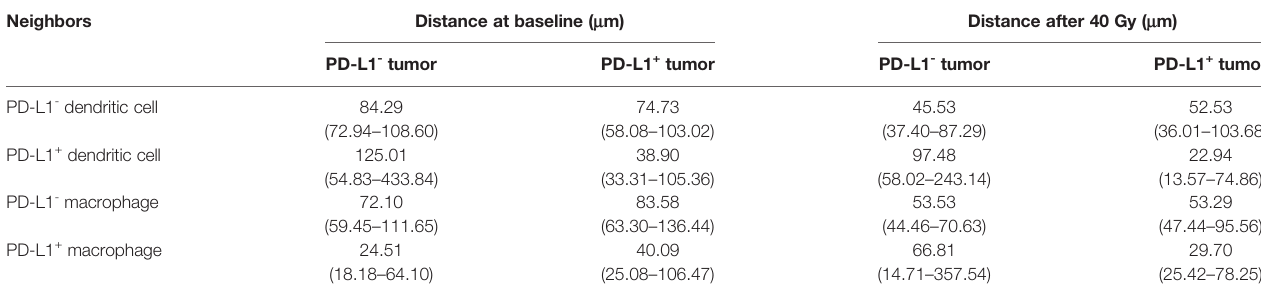
TABLE 2 | Nearest distance from PD-L1 - and PD-L1 + tumor cells to neighbors.